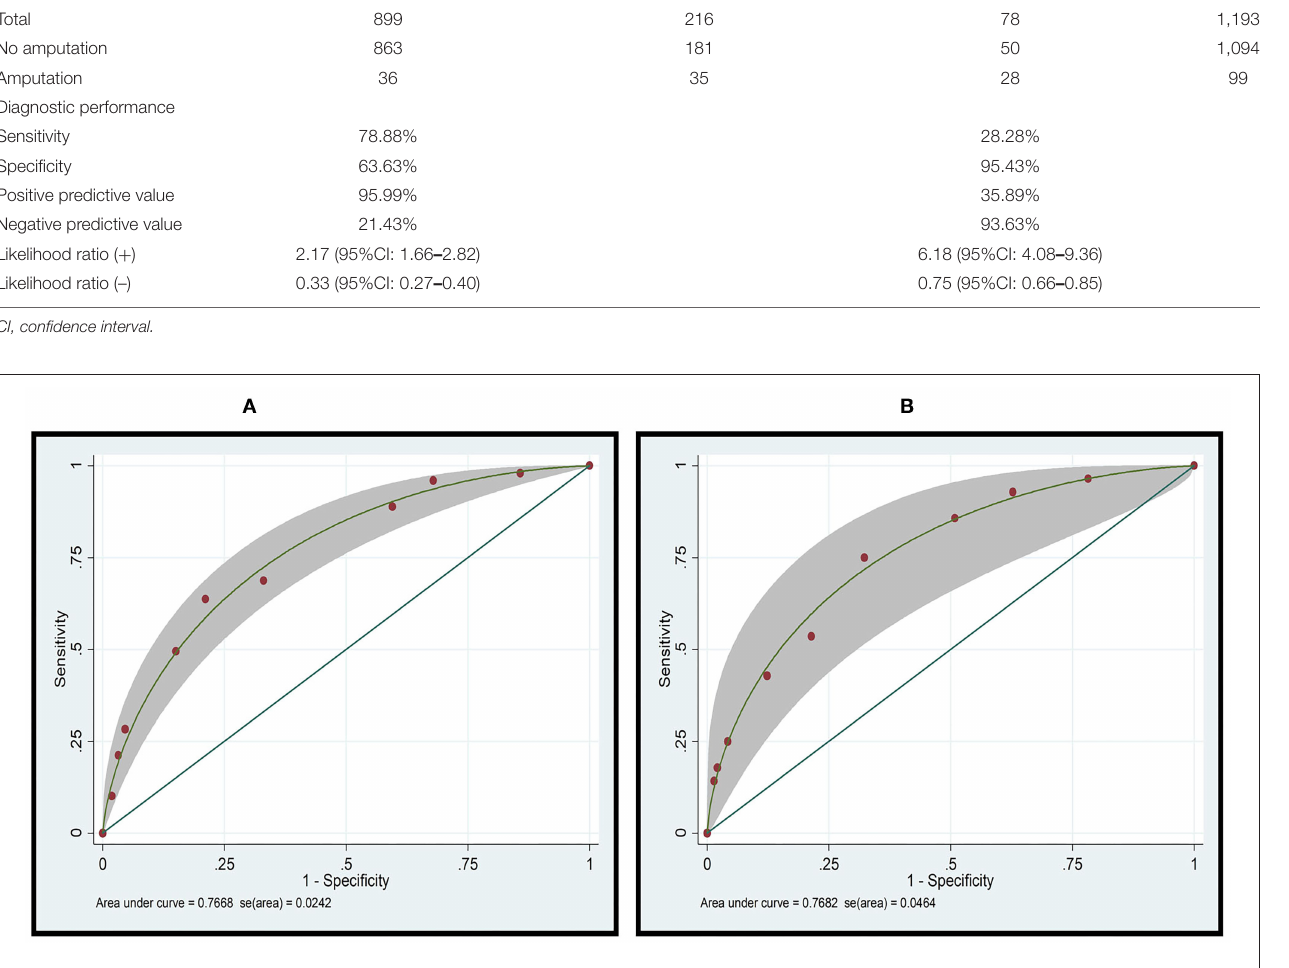
FIGURE 1 | Receiver operator characteristic (ROC) curve analysis of the ANF risk scoring system for predicting amputation in patients with necrotizing fasciitis in the (A) derivation cohort ( n = 1,193), and the (B) validation cohort ( n =